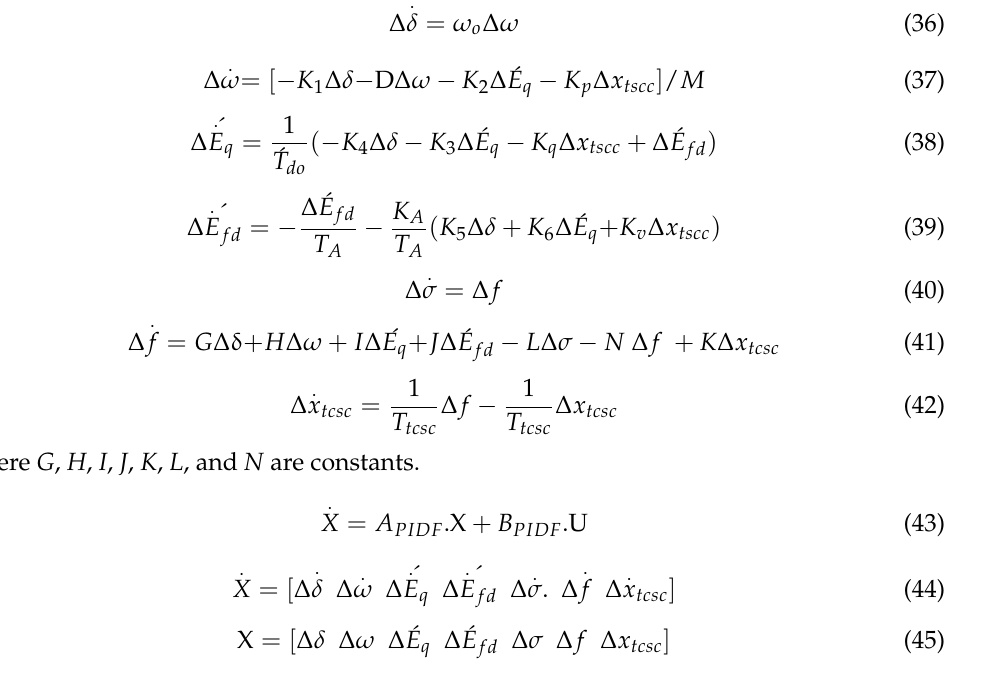
Figure 4. Block diagram of the TCSC PIDF controller. The values of Equation (26) are placed in Equation (35), and Equations (36)–(42) are the extended Phillips–Heffron model of the single-machine infinite-bus power system installed with a PIDF controller and TCSC stabiliser.